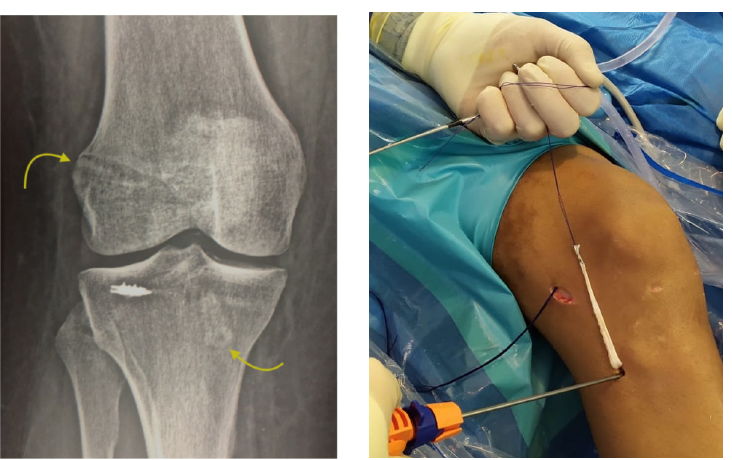
Figure 4. Anterolateral fixation of the plasty at the time of lateral extra-articular (LET) (see footprint selection on the text). Arrows show femur and tibia tunnels with two interence screws fixation across out-in technique. Minimally invasive surgery for introducing the TWINFIX into the bone is showed.